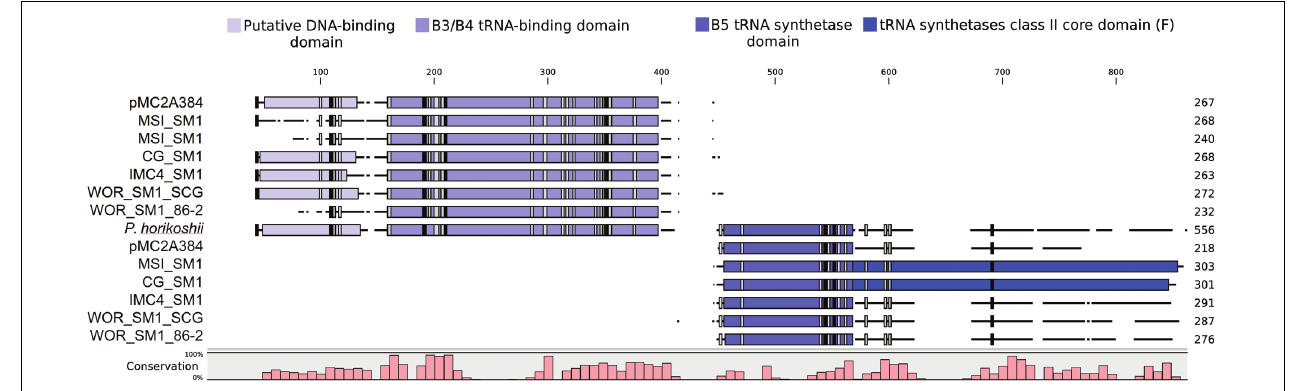
FIGURE 4 | The amino acids of phenylalanine tRNA-synthetase beta subunit ( pheT ) in six proposed Altiarchaeales genomes, were aligned using ClustalO to 104 pheT sequences from one representative of each archaeal genus with draft or finished genomes above 50% completeness, but only pheT from Pyrococcus horikoshii is shown. Each aligned gene is labeled by genome name, and the length scale is in amino acids. Colored boxes placed over the aligned sequences represent protein domains associated with pheT (InterProScan5). Black and gray boxes denote the presence of conserved residues found in 100 or 90% of archaeal pheT , respectively. The histogram tracks the relative conservation of residues across all aligned archaeal pheT